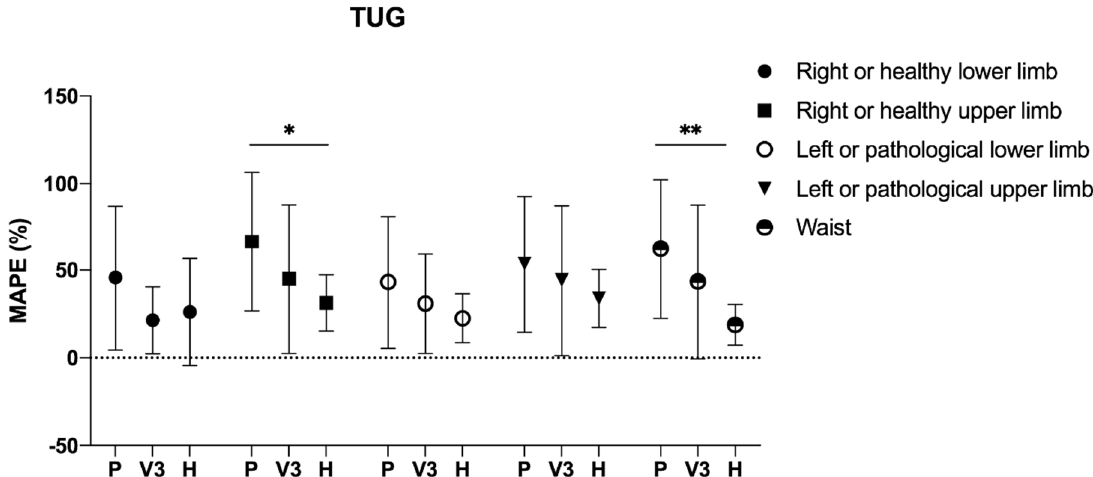
Figure 3. Comparison of the mean absolute percentage error in the timed up and go test for the healthy group ( n = 10), pathological group ( n = 43), and group V3 ( n = 17). Legend: P: pathological group; H: healthy group; *: p < 0.05; **: p < 0.001.